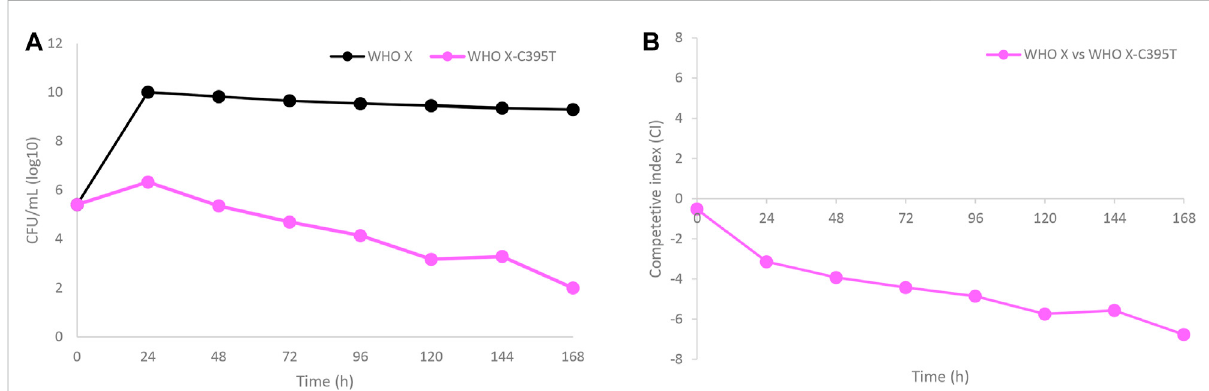
FIGURE 5 (A) Growthcurvesofthetotalpopulationofthelefamulin-susceptible Neisseriagonorrhoeae WHOXreferencestrain(blackline)andthe invitro selected lefamulin-resistant WHO X-C395T mutant (purple line), when cocultured in the same hollow fi ber infection model (HFIM) cartridge and followedfor7 days. (B) Competitiveindexforthelefamulin-susceptible Neisseriagonorrhoeae WHOXreferencestrainandtheoutcompeted invitro selected lefamulin-resistant WHO X-C395T mutant, when cocultured in the same HFIM cartridge and followed for 7